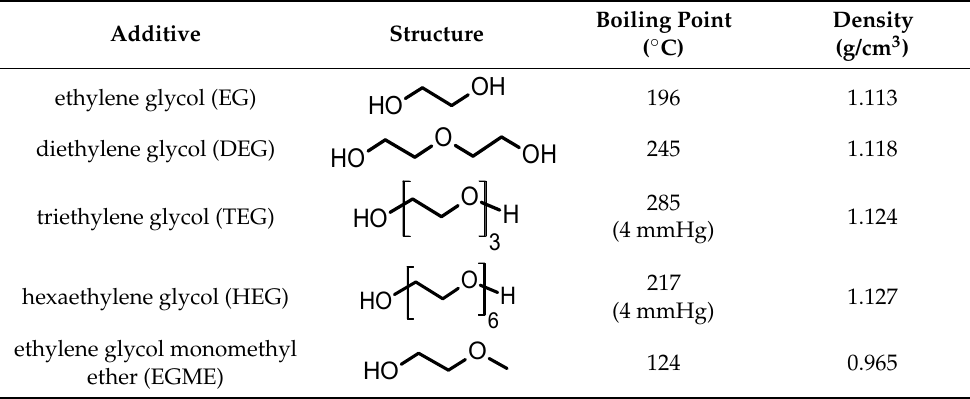
Table 1. Chemical structures, boiling points, and density of the additives.